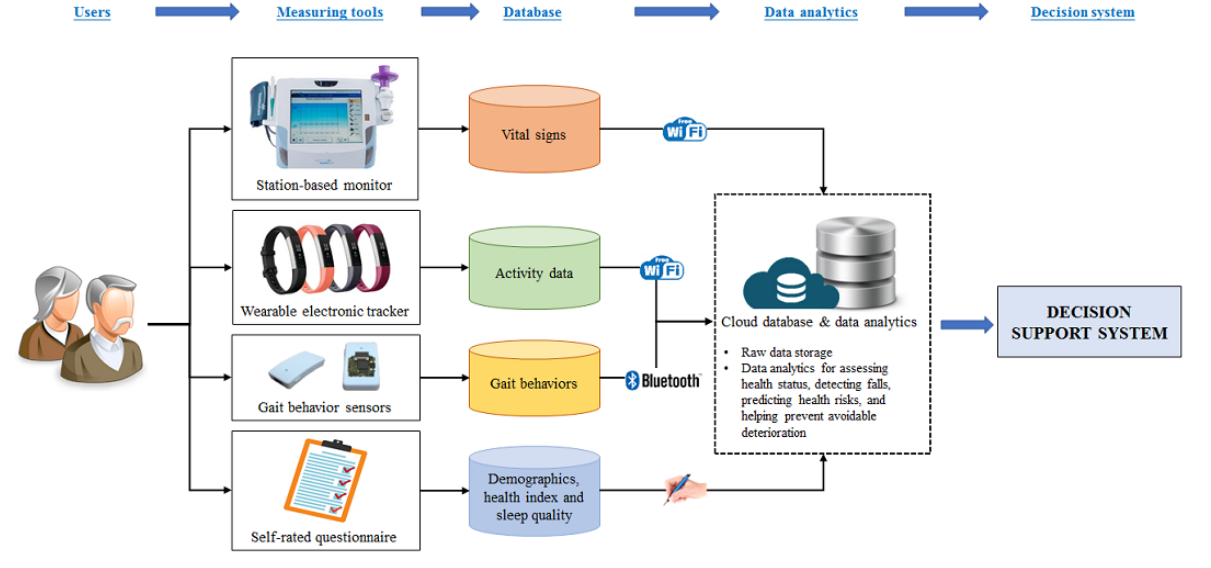
Figure 1. Schematic diagram of the proposed personalized health monitoring system.